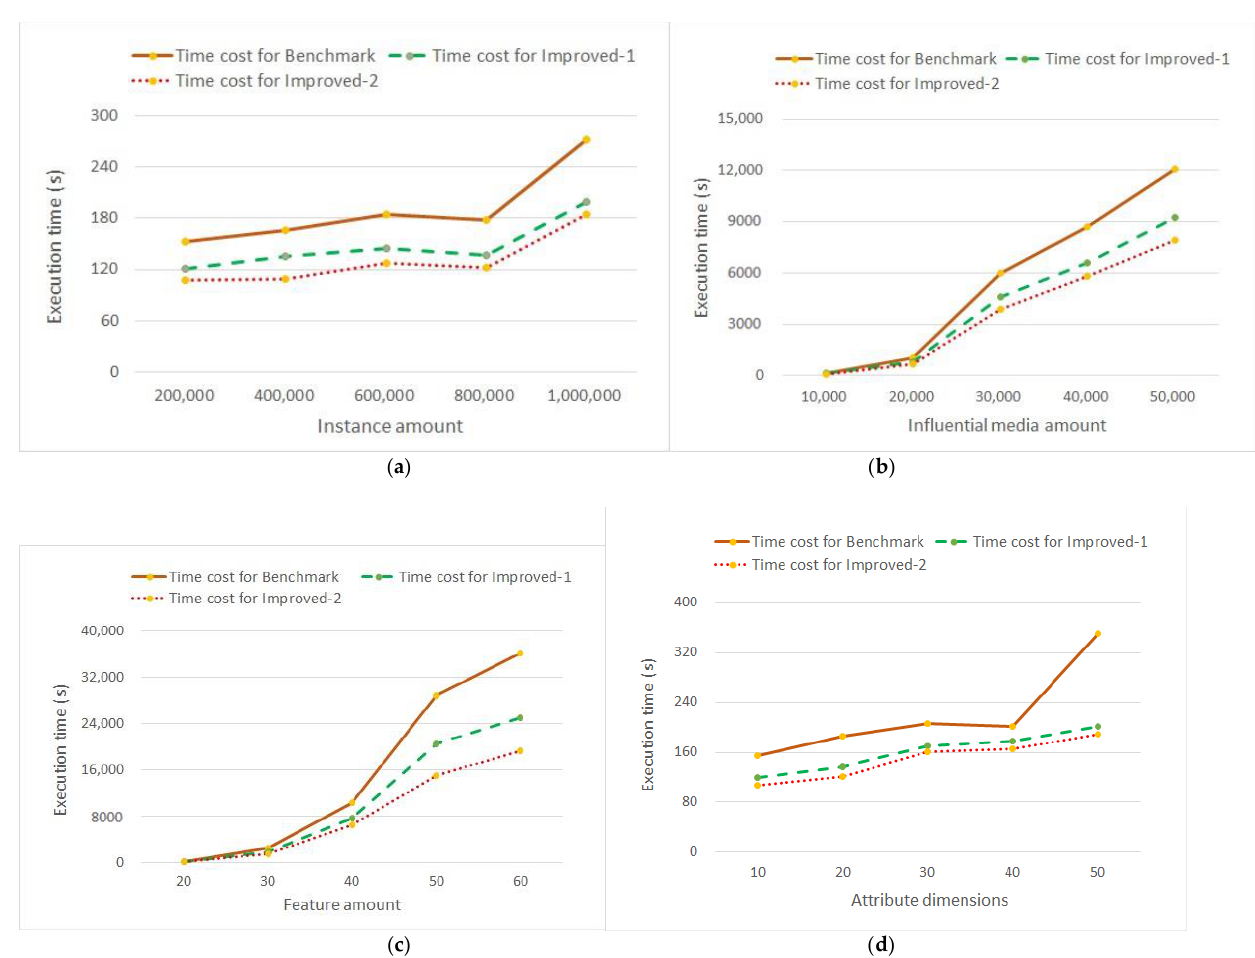
Figure 9. Comparison of the scalability of high IP mining algorithms with variations of: ( a ) instance amount, ( b ) influential media amount, ( c ) feature amount, and ( d ) attribute dimensions.